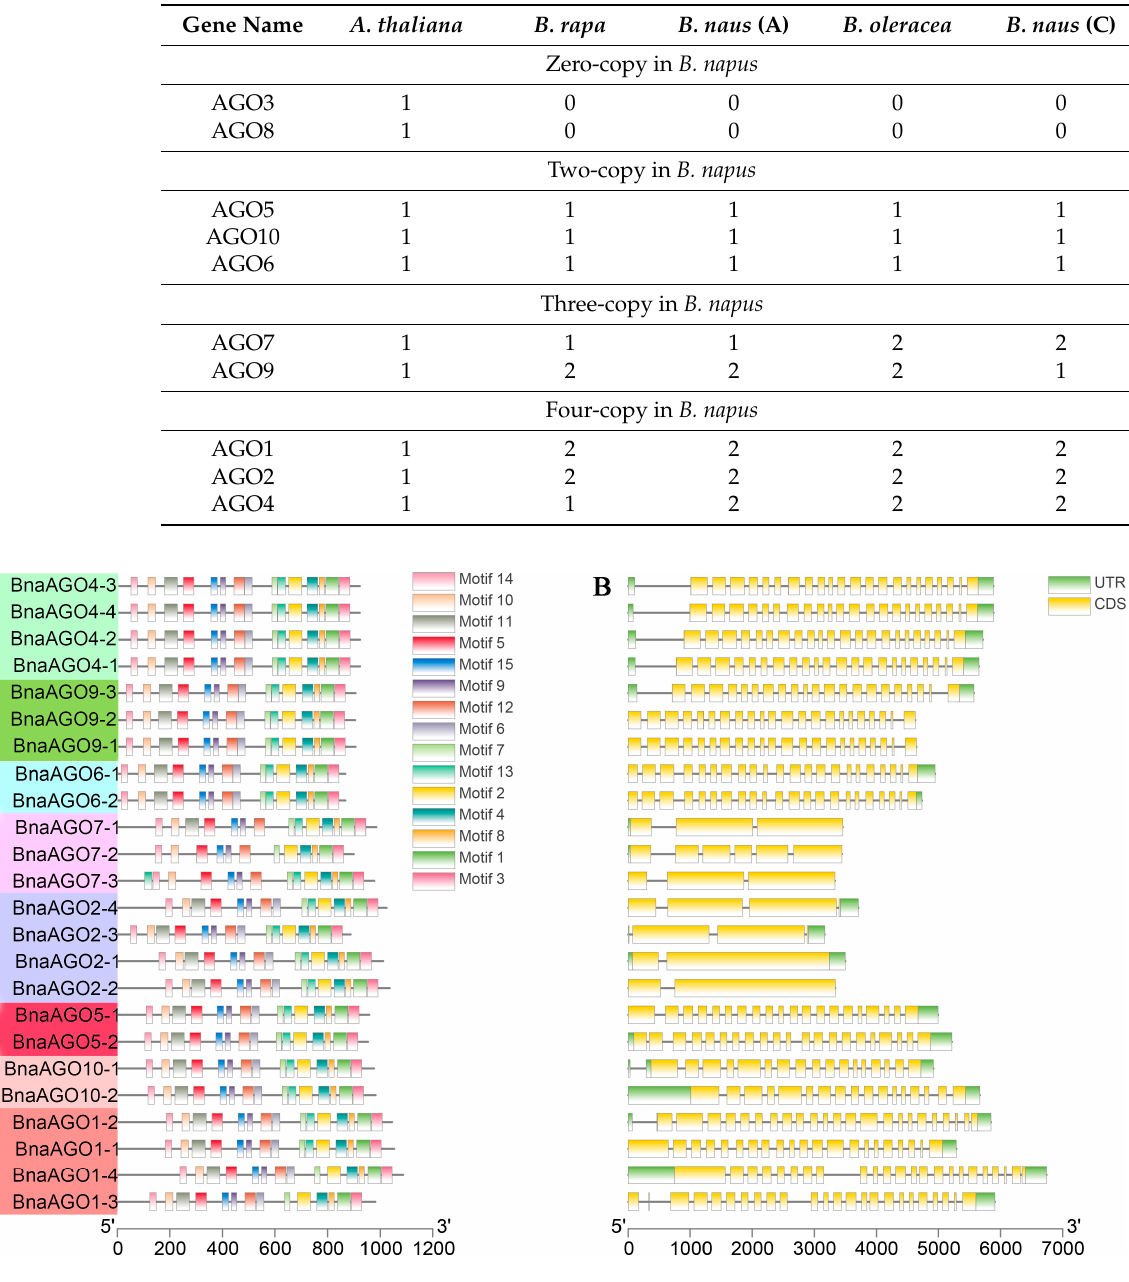
Table 1. The copy number of AGOs among A. thaliana , B. rapa , B. oleracea , B. napus with A and C